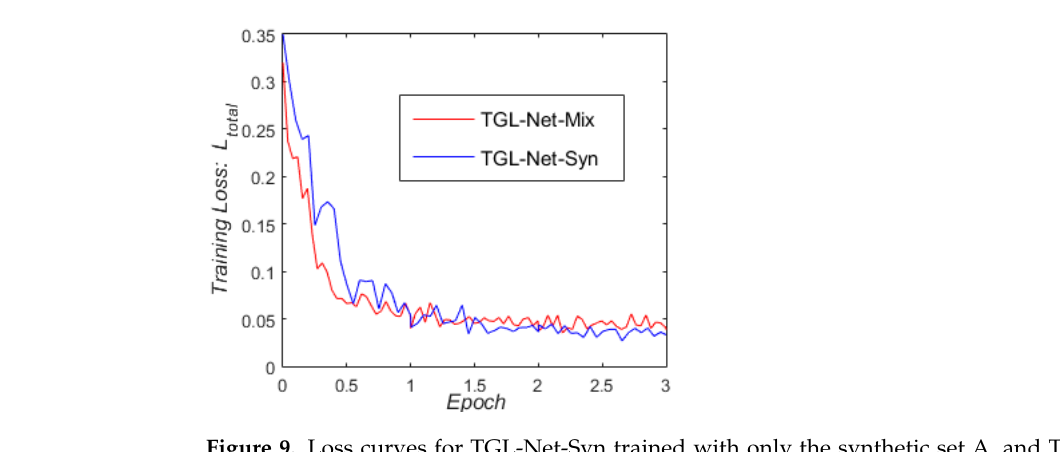
Figure 9. Loss curves for TGL-Net-Syn trained with only the synthetic set A, and TGL-Net-Mix trained with a combination of both the synthetic image set A and the real-world image set B.